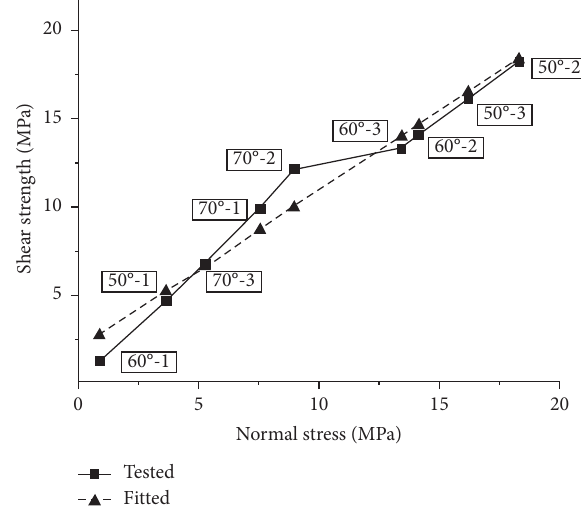
Figure 8: Fitting result for the interface shear